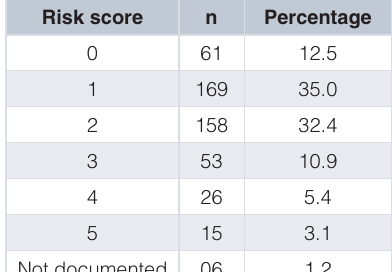
Table 10. Risk scores used to assess the future safety of the women (n=488).